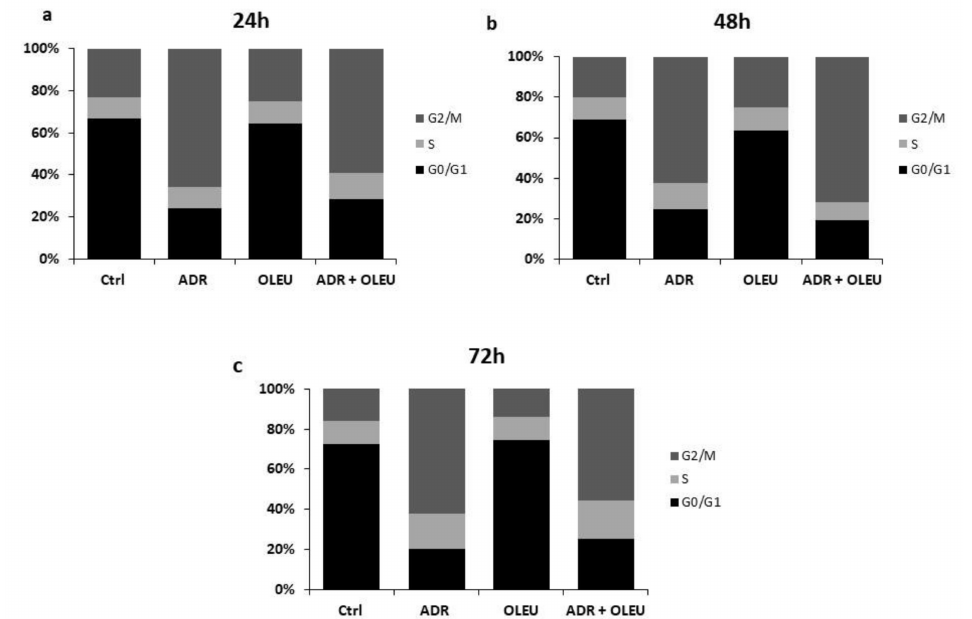
Figure 2. Flow cytometry graphs showing DNA content in MG-63 cells, after ( a ) 24 h, ( b ) 48 h and ( c ) 72 h of exposure to ADR (Adriamycin) and OLEU (Oleuropein), alone and in co-treatment, in comparison to control cells (Ctrl). G0: gap0, G1: gap1, G2: gap2, M: mitosis, S: